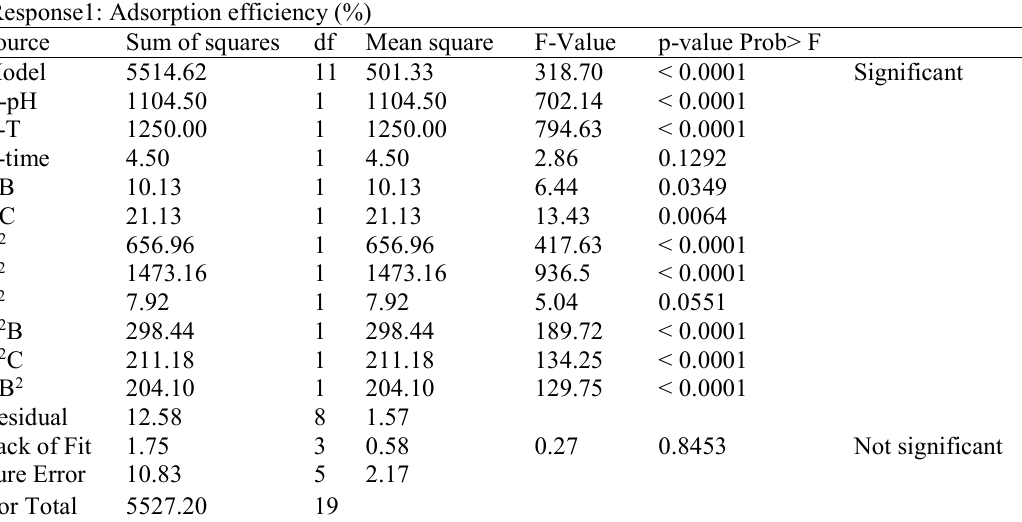
Table 3. Analysis of variance for the response surface reduced cubic mode Response1: Adsorption efficiency